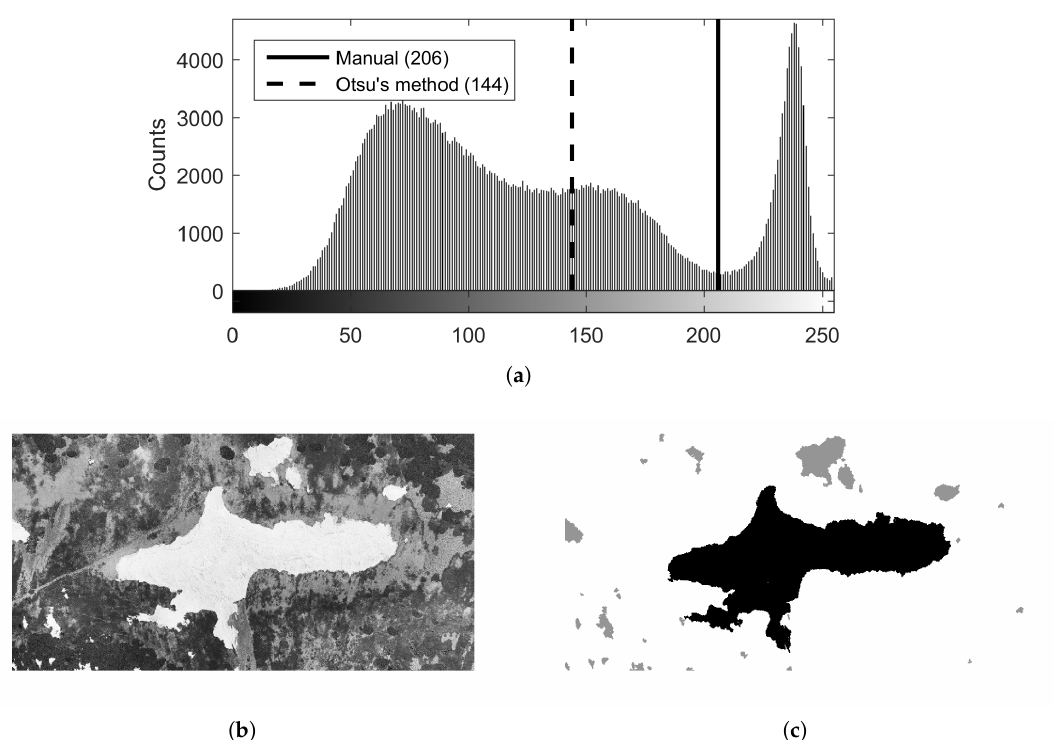
Figure 13. The histogram ( a ) of the gray-scaled orthophoto ( b ), with the snow-covered area extracted (the snow field is highlighted in black) ( c